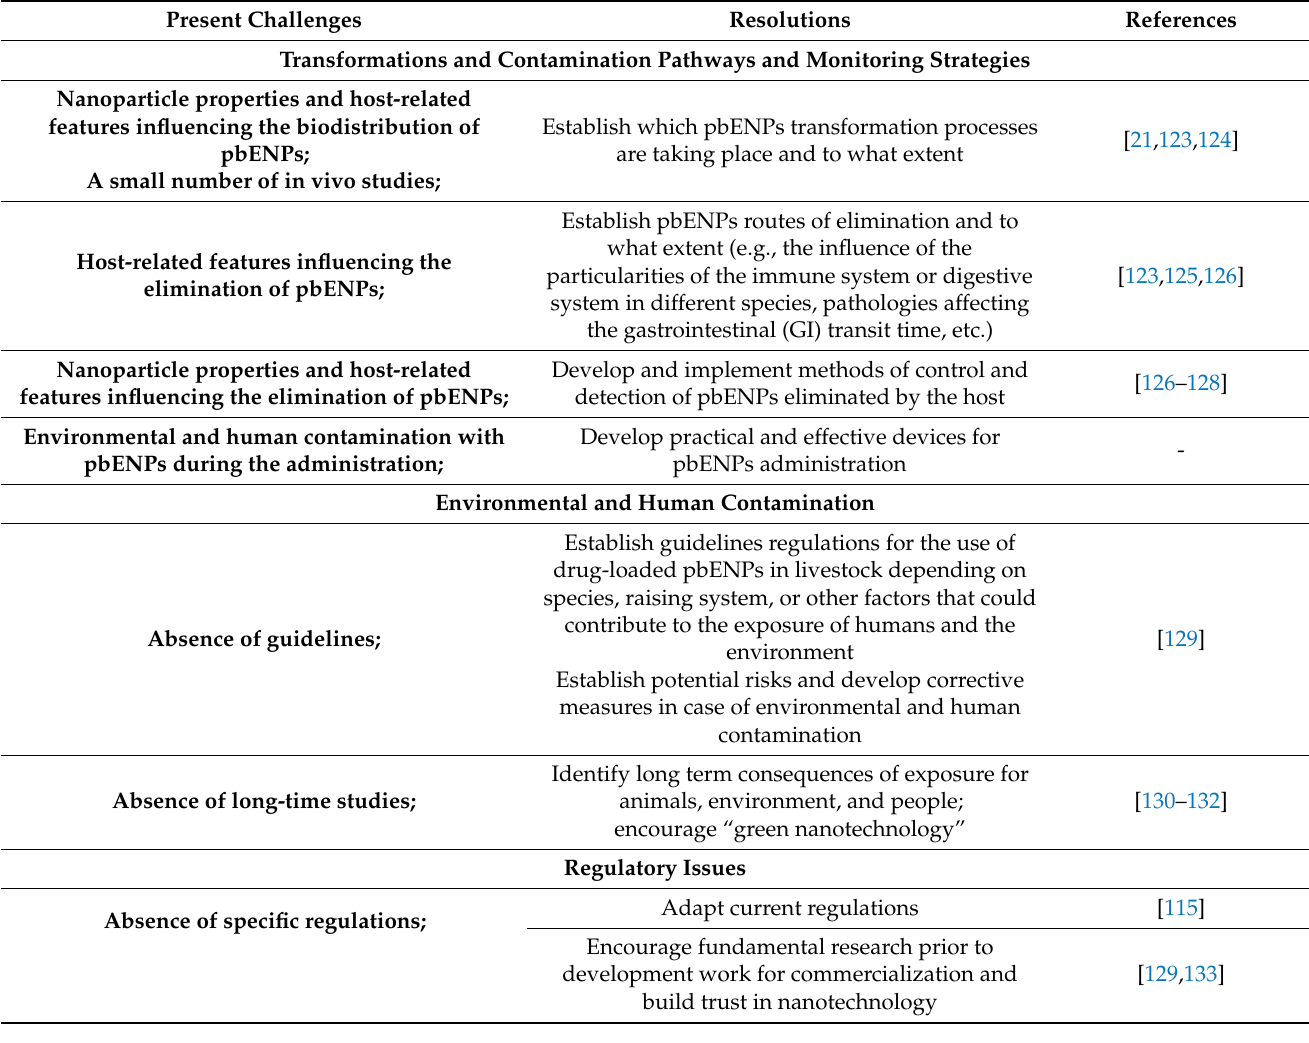
Table 2. Overview of identified challenges posed by pbENPs, as well as the resolutions from a One Health